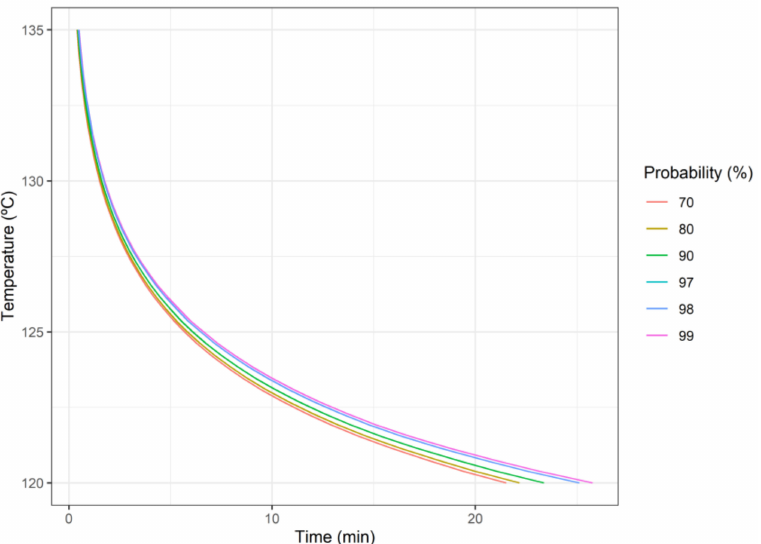
Figure 1. Probability of six or more logarithmic reductions P ( log 10 S ≥ 6 ) for Geobacillus stearother- mophilus as a function of heat treatment (time,